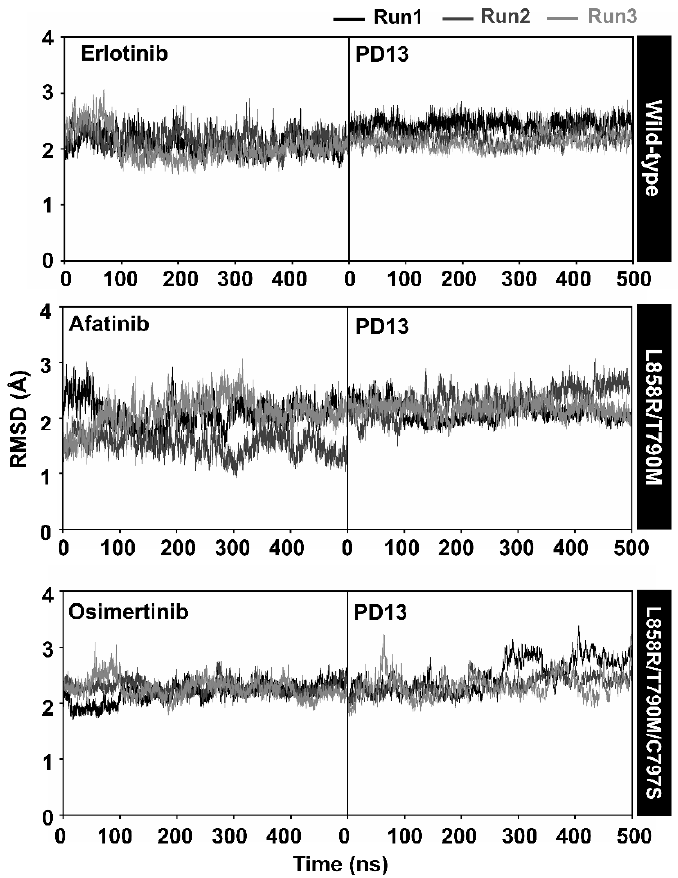
Figure 4. All-atom RMSD of EGFRs with PD13 and drugs during 500 ns of simulation from three independent simulations.